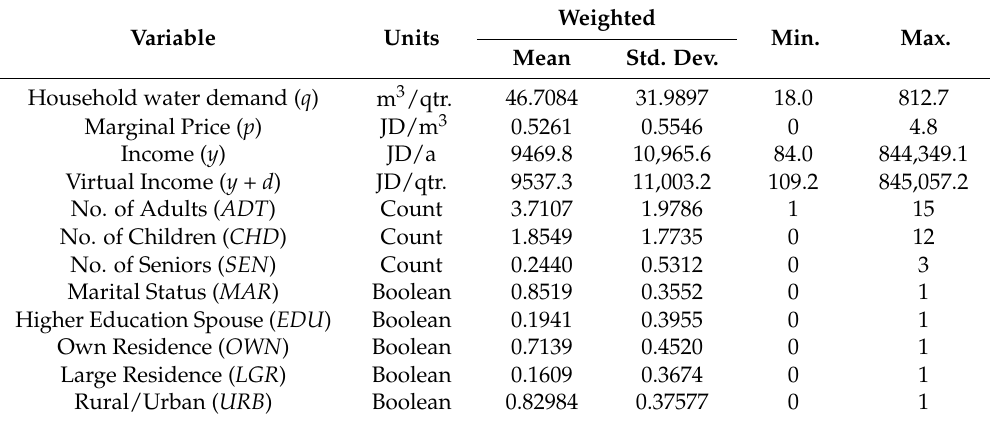
Table 1. Descriptive statistics for relevant variables in the Jordan Household Expenditure and Income Surveys 2002, 2006, 2008, 2010, and 2013. Weighted Variable Units